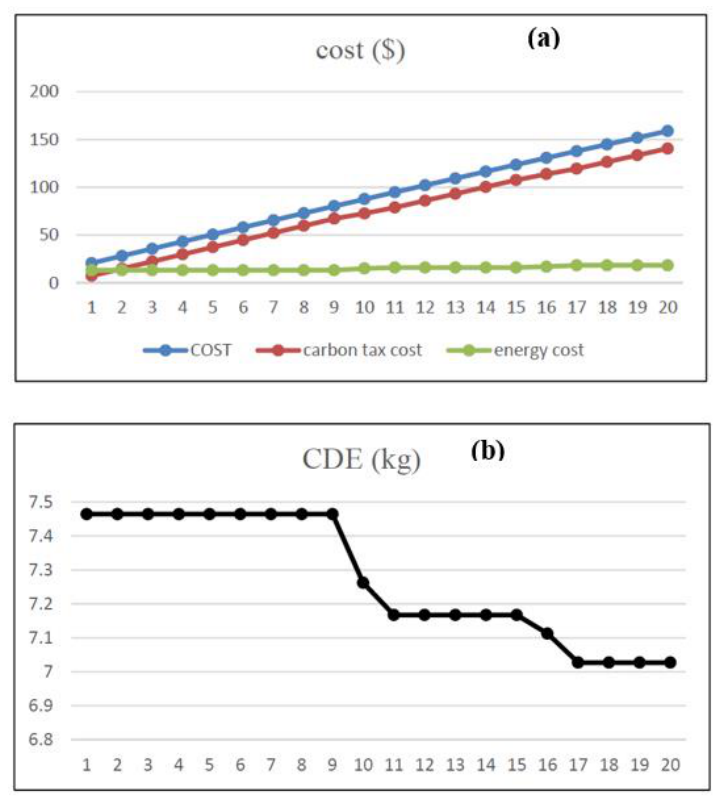
Figure 4. Impact of different carbon taxes on ( a ) total costs and ( b ) carbon taxes on CDE [123].